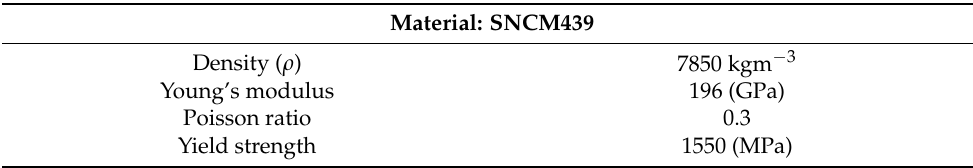
Table 2. Material properties of SNCM439.